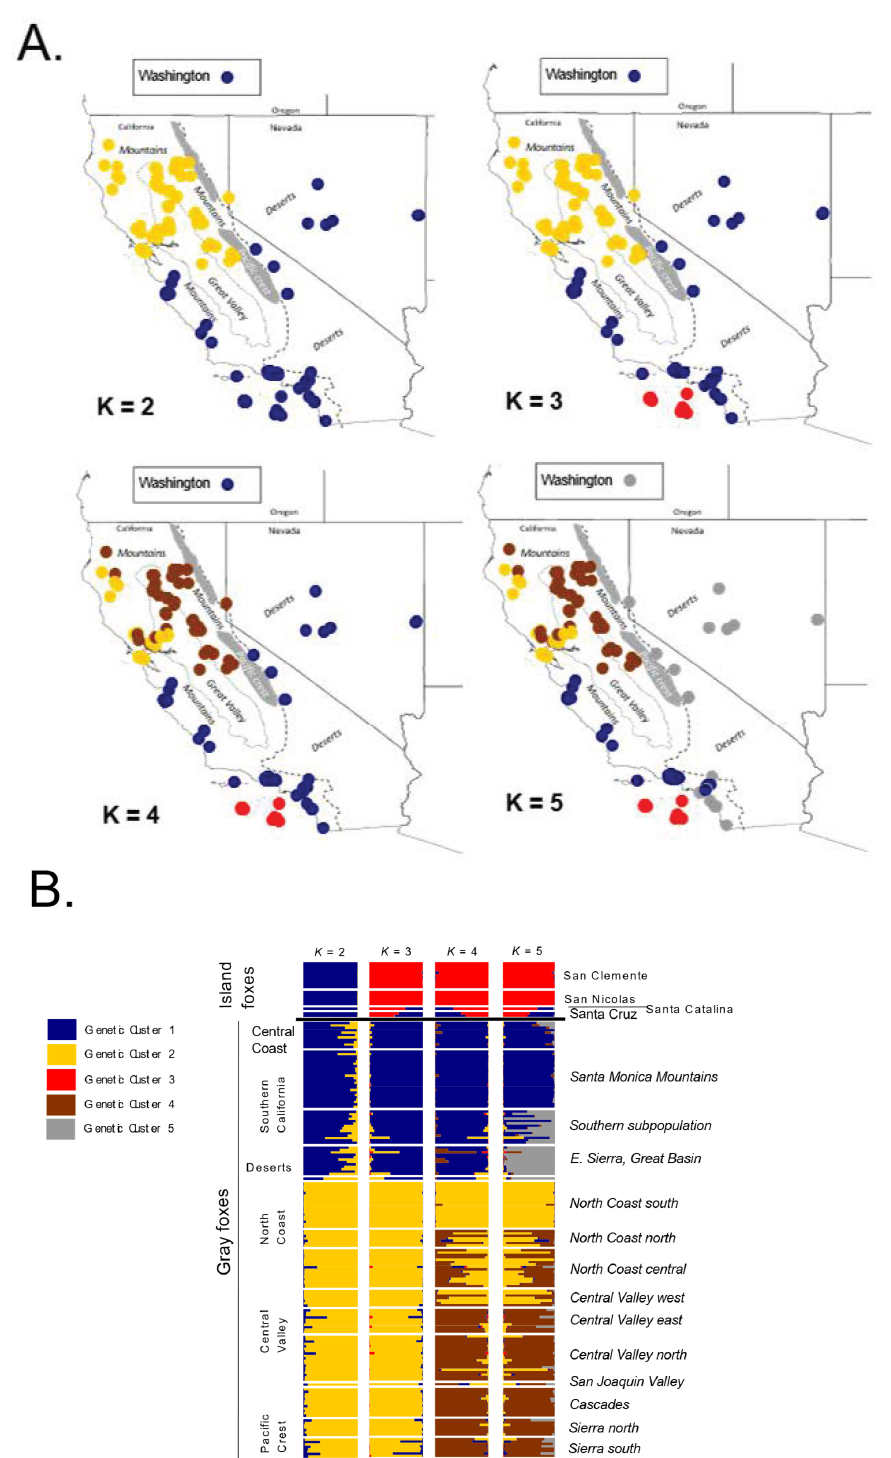
Figure 3. Admixture analysis of 188 western gray foxes ( Urocyon cinereoargenteus ) and island foxes ( U. littoralis ) with 20 microsatellite loci conducted in program Structure, assuming K = 2, 3, 4, and 5 clusters. ( A ). Sample locations represented on maps as dots colored corresponding to the genetic cluster with the highest q -value. ( B ). Horizontal bar charts showing q values for all clusters assigned to each fox, arranged by species (island fox, top; gray fox bottom) and gray fox population (left) and subpopulation (right). Log probability of the data (SD) for K = 1–10 were as follows: − 11,828 (1.59), − 10,943 (2.1), − 10,268 (7.71), − 10,047 (2.04), − 10,010 (14.48), − 9982 (24.76), − 9896 (69.98), − 9976 (96.81), − 9944 (204.73), and − 10,320